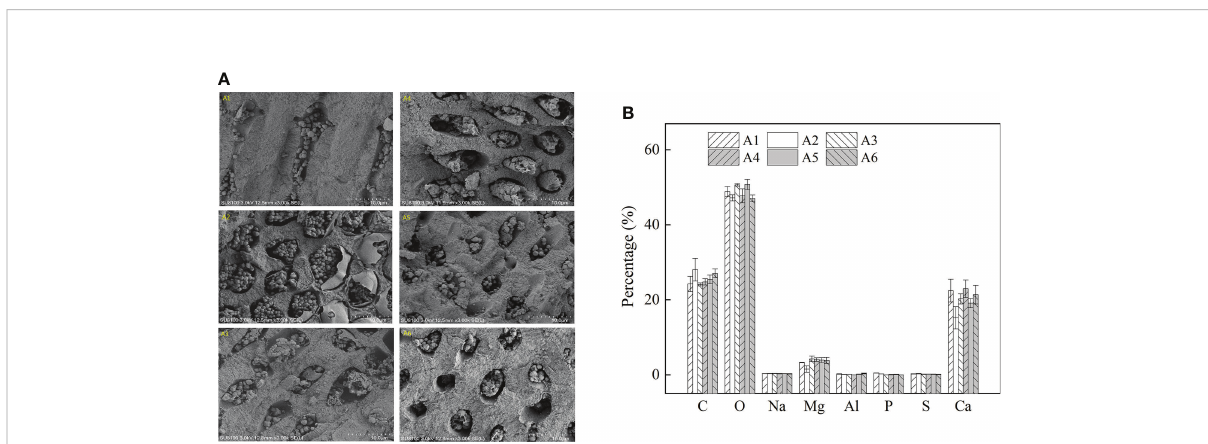
FIGURE 7 The (A) SEM pictures and (B) relative abundance (%) of main elements in the unpigmented skeletal layer under different temperature and light by SEM-EDS (A1: 60 m mol photons m − 2 s − 1 , 26°C; A2: 80 m mol photons m − 2 s − 1 , 26°C; A3: 120 m mol photons m − 2 s − 1 , 26°C; A4: 60 m mol